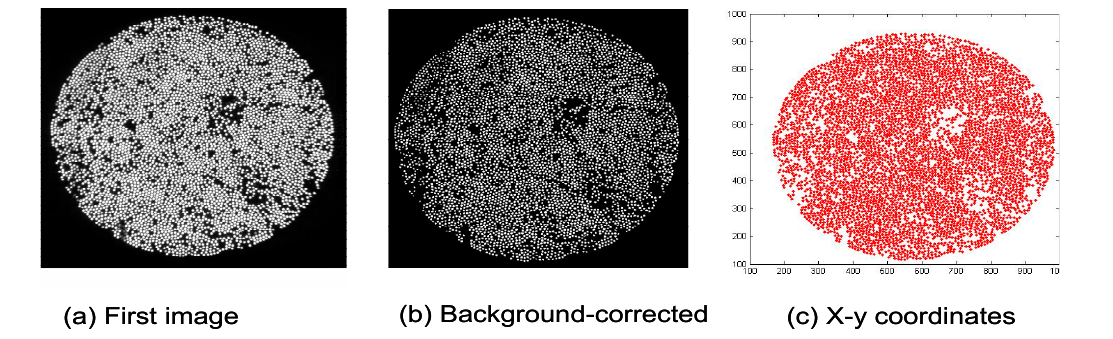
Figure 5. ( a – c ) Illustration of the analysis steps involved with processing the images obtained via the high-speed camera: ( a ) image from the high-speed camera at t = 0 (first image); ( b ) background-corrected image using Matlab™ ; and ( c ) x-y plot for the location of the individual